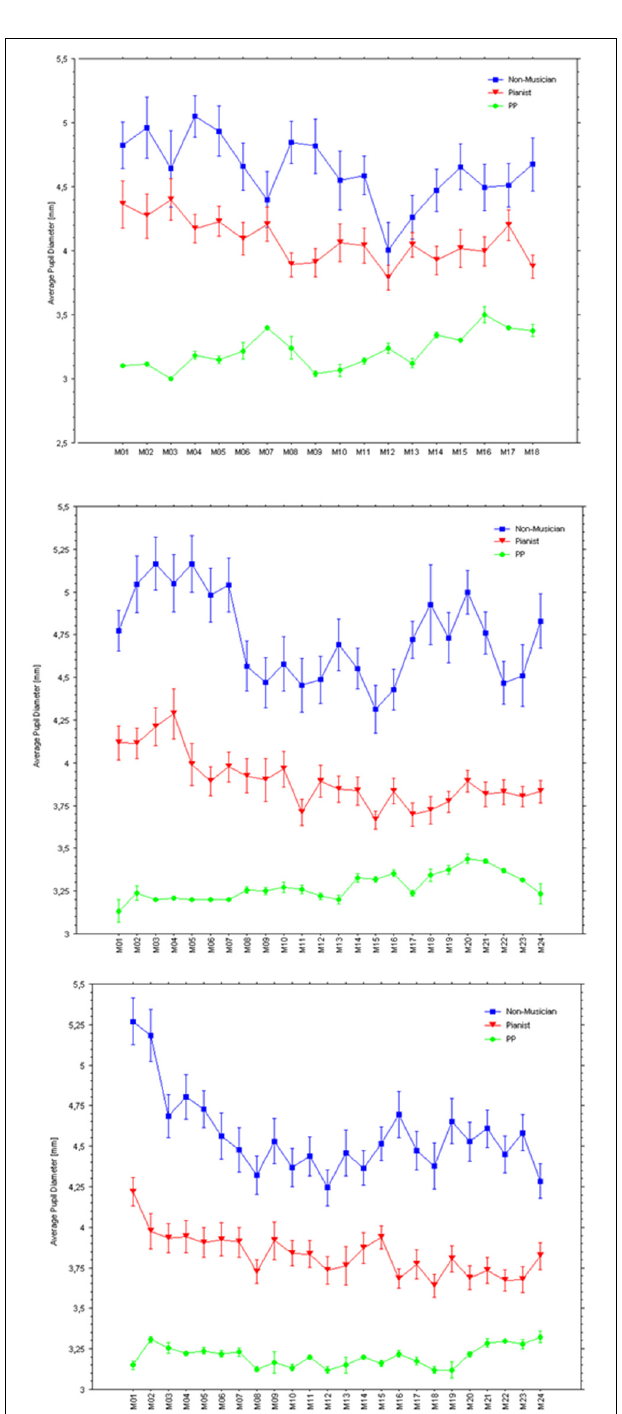
FIGURE 8 | Average pupil diameters in mm (bars are SEs) within each measure while listening to PP’s playing with a sound each of the three pieces (Holberg Suite: top panel; Träumerei: middle panel; Wächterlied: bottom panel).